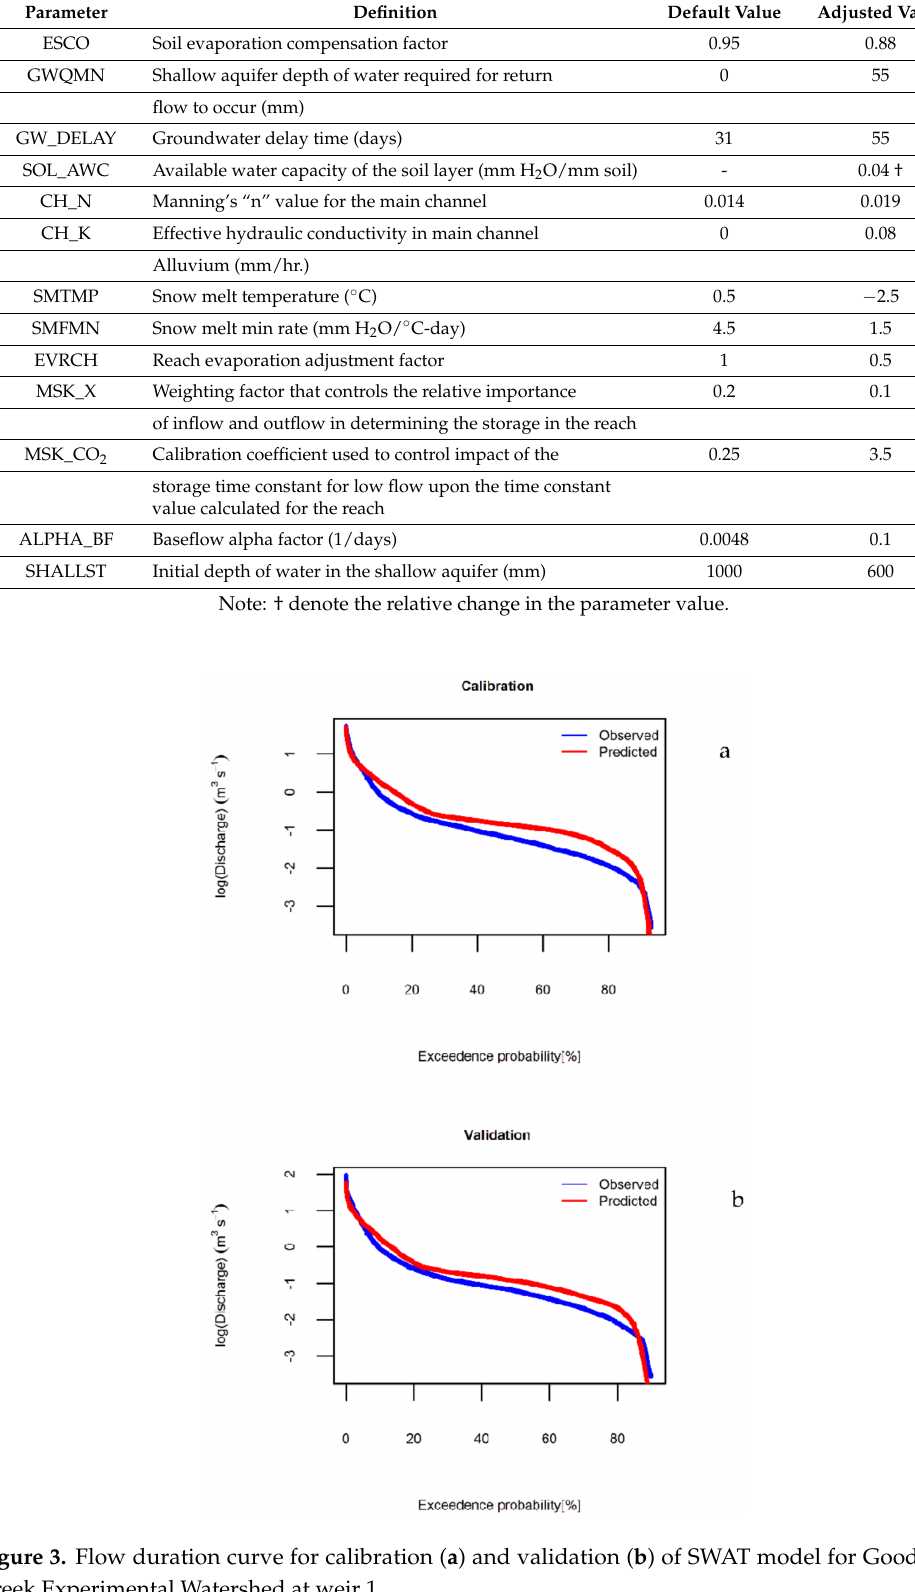
Table 4. Sensitivity results of key SWAT parameters for stream discharge in the Goodwater Creek Experimental Watershed including the default values.